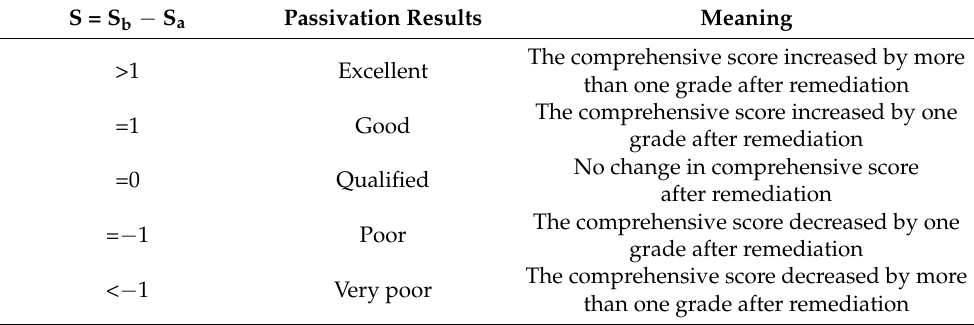
Table 8. Reference table for evaluation of stabilization results.